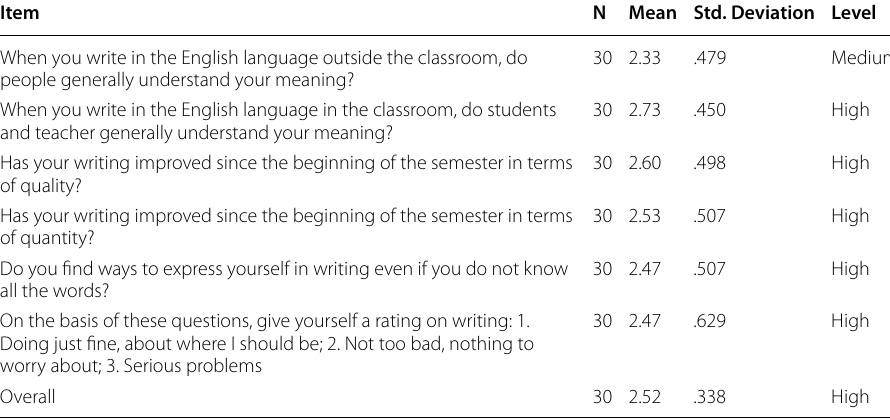
Table 4 Descriptive statistics of the self‑evaluation questionnaire Item N Mean Std. Deviation